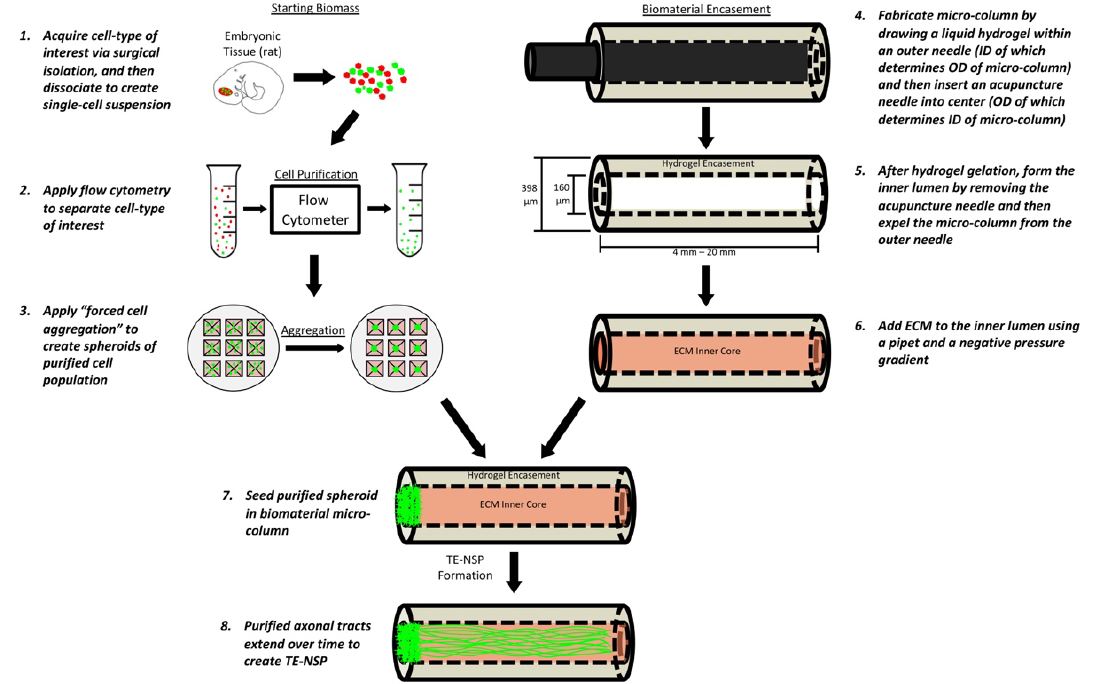
Figure 1. Fabrication of TE-NSPs. In order to create the cell aggregates, cells are first obtained from the ventral mesencephalon of transgenic rat embryos. In order to enrich the cell population for dopaminergic neurons, the cells are dissociated and run through a flow cytometer where fluorescent labels can be used to perform FACS. The purified cells are then centrifuged in custom, inverted PDMS wells to create cell aggregates. In order to generate the biomaterial micro-columns, agarose is gelled in a capillary tube containing a needle. Once the agarose has hardened, the needle is removed to create a hollow agarose tube, which is then filled with an ECM core. Lastly, the aggregates are inserted into the ends of the tubes, where they extend neurites over days to weeks in vitro. Utilizing the forced neuronal aggregation technique that we previously optimized with the standard population [19], we were able to fabricate TE-NSPs displaying the desired cytoarchitecture with the enriched population (Figure 2b). These TE-NSPs extended robust processes along the length of the micro-column and remained healthy for at least several weeks in culture. Indeed, a LIVE/DEAD assay revealed an average cell viability of 85.2 ± 6.1 % (mean ± standard deviation) out to 14 days in vitro (DIV) (Figure 2c). Importantly, this protocol yielded a neuronal population containing an average of approximately 60% dopaminergic neurons (Figure 2d).